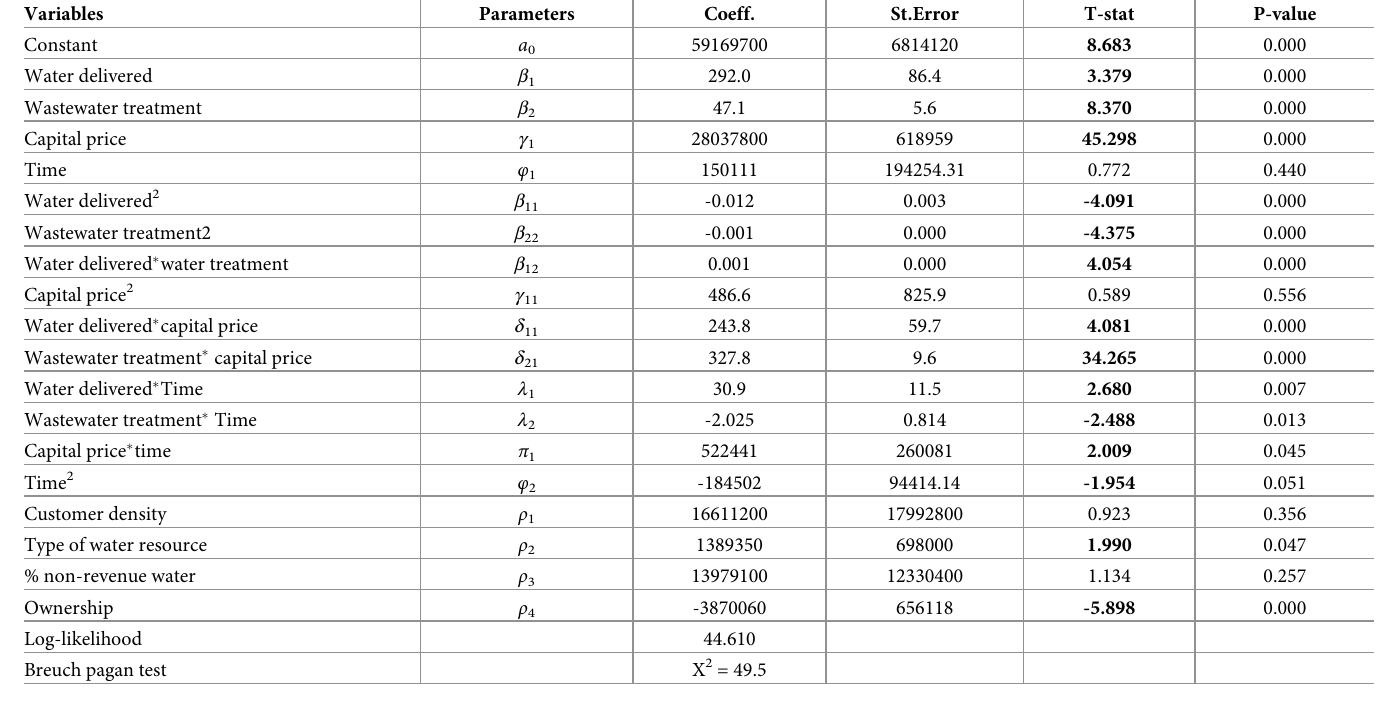
Table 2. Estimated parameters of the normalized quadratic cost